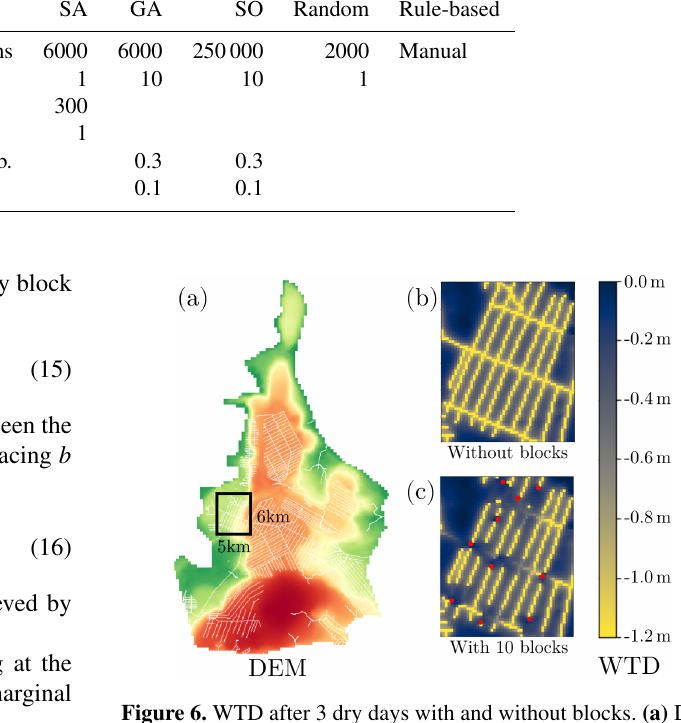
Figure 6. WTD after 3 dry days with and without blocks. (a) DEM (colored) with the canal network superposed (white) and a rectan- gle indicating the area shown on the right. (b) WTD after 3 dry days without any blocks. (c) WTD after 3 dry days in the same area with 10 blocks (block locations are indicated by red dots). WTD in the canal raster is defined as v (cid:48) − s . Blocks help raise the WTD closer to the surface, but their effectiveness varies depending on the local